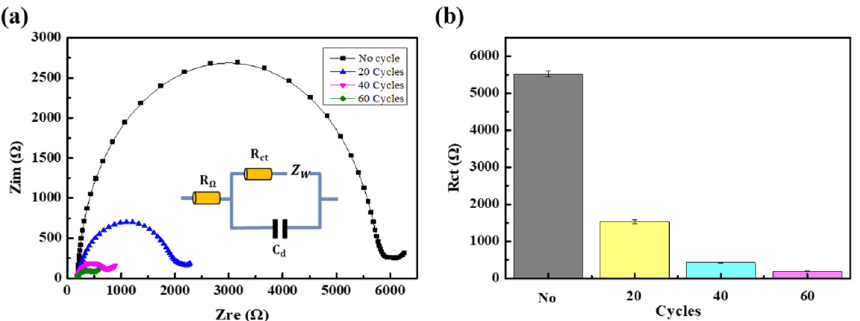
Figure 4. ( a ) Nyquist plots. ( b ) R ct values before using dip coating and after dip coating forv20, 40, and 60 cycles.